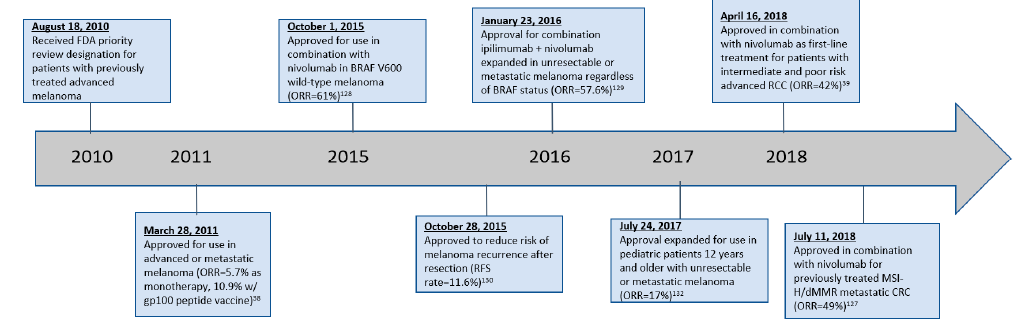
Figure 2. Timeline of ipilimumab FDA approvals.